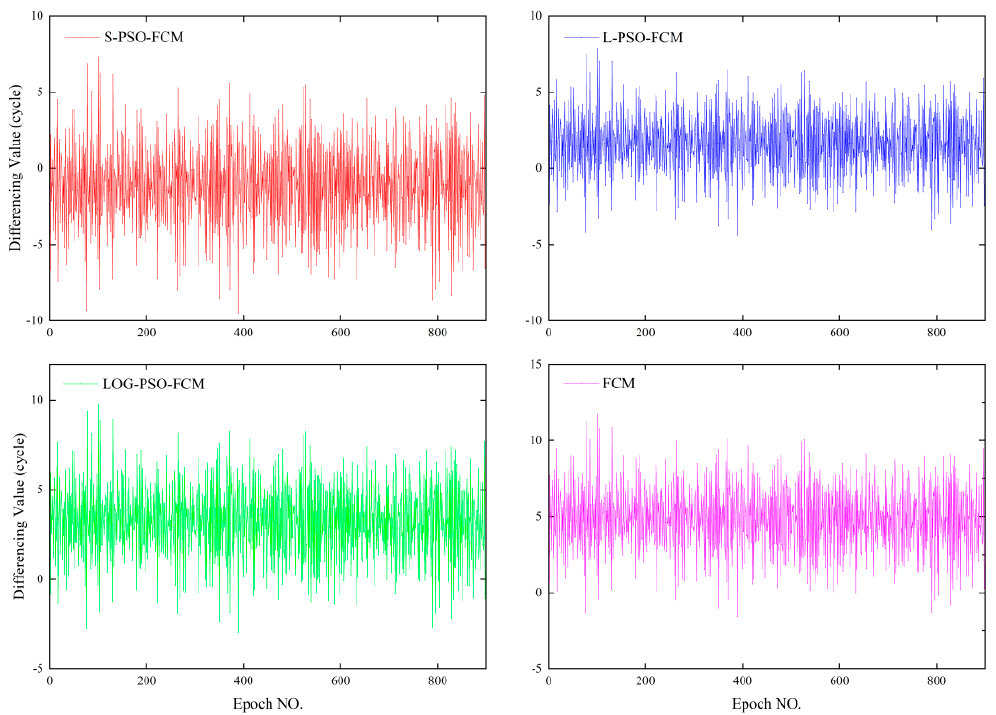
Figure 11. Differencing values calculated by four algorithms under the ultra-long baseline scenario.